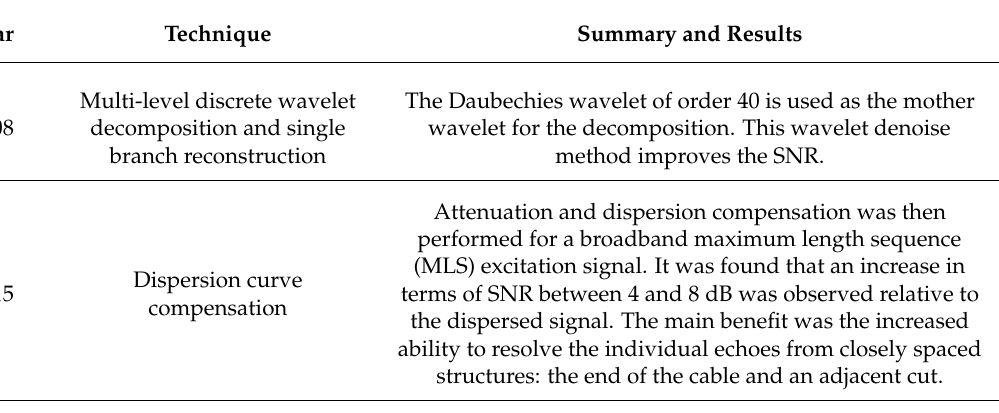
Table 4. Works found addressing signal processing techniques applied to other